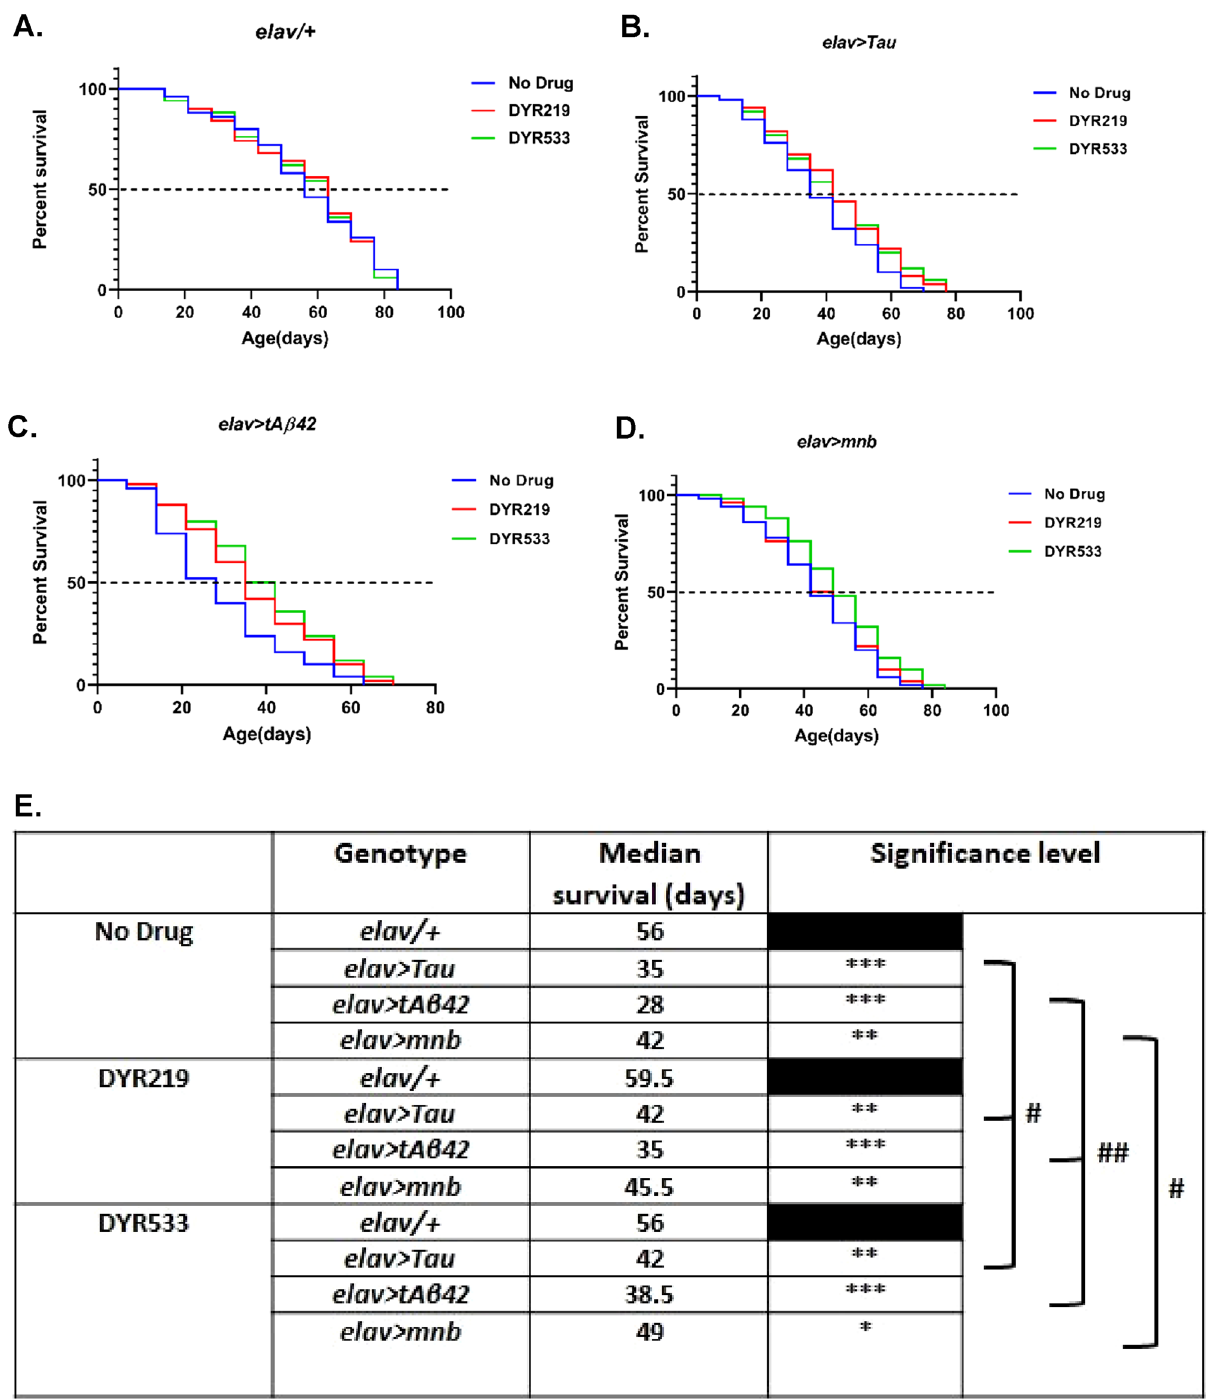
Figure 3. Pan-neuronal overexpression of human Tau, amyloid-β42 and mnb shortened lifespan which was partially reversible by DYRK1A inhibitor. Mantel-Cox (Log-rank) survival plots of ( A ) control ( elav-Gal4/ +) compared to flies overexpressing: human Tau ( B ), human tAβ42 ( C ) and fly mnb ( D ) off drug (blue lines) compared to treated with DYR219 (red) and DYR533 (green), a rightward shift in the curve indicates an extension of life. All genotypes and treatments were performed in parallel. ( E ) Table showing quantification of lifespan by median survival (days) which is reduced by pan-neuronal overexpression of Tau, tAβ42 and mnb compared to elav-Gal4/ + control. DYR533 was found to be effective at extending the lifespan of all disease models while DYR219 lengthened the life of human Tau and human tAβ42 overexpressing flies ( # P < 0.05 and ## P < 0.01 with n = 5 biological replicates per condition of 10 flies per replicate for all